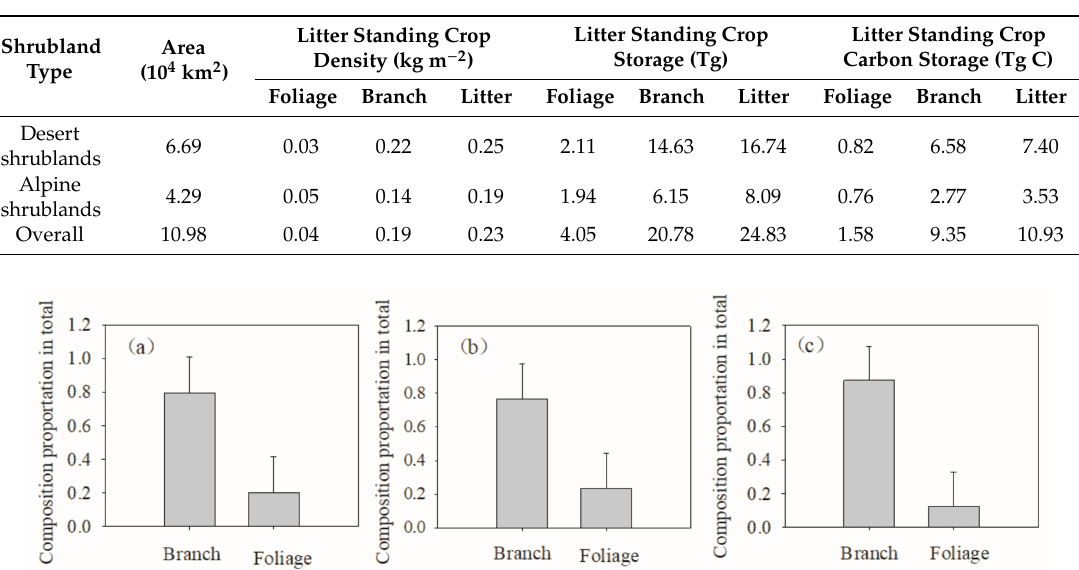
Table 1. Size, storage and carbon storage of foliage, branch, and litter standing crops in the shrublands of the Tibetan Plateau.